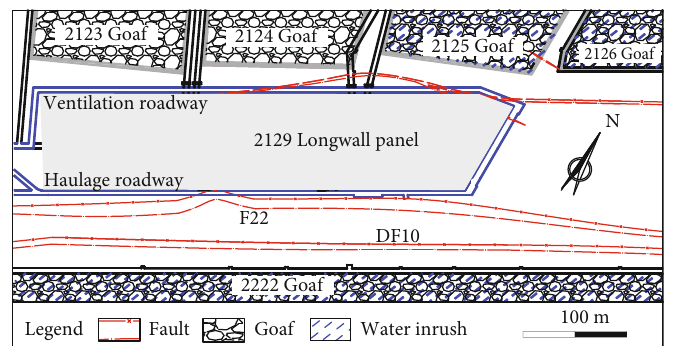
Figure 1: Location of the study